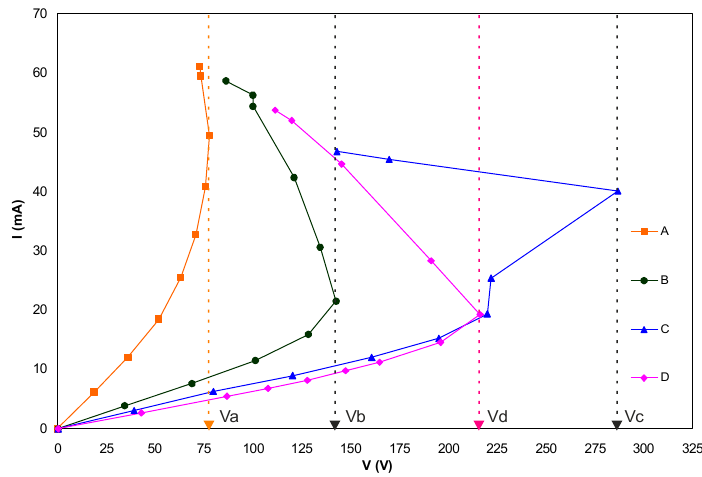
Figure 3. Current intensity versus voltage for samples A, B, C, and D.